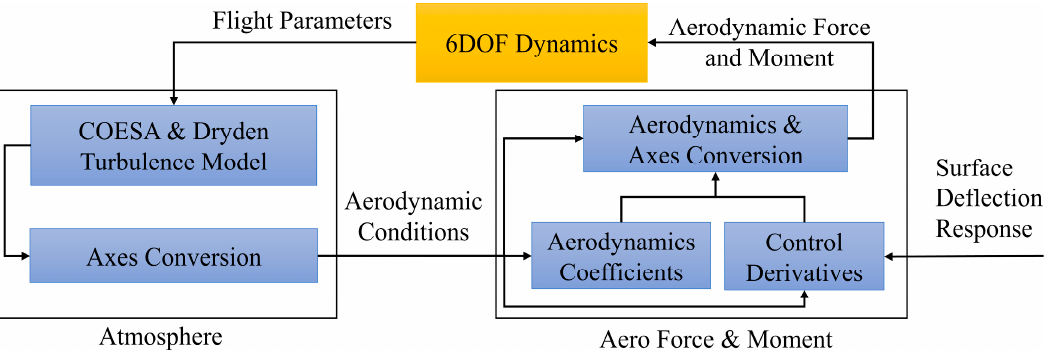
Figure 2. The interaction between the Atmosphere and Aero Force and Moment modules.